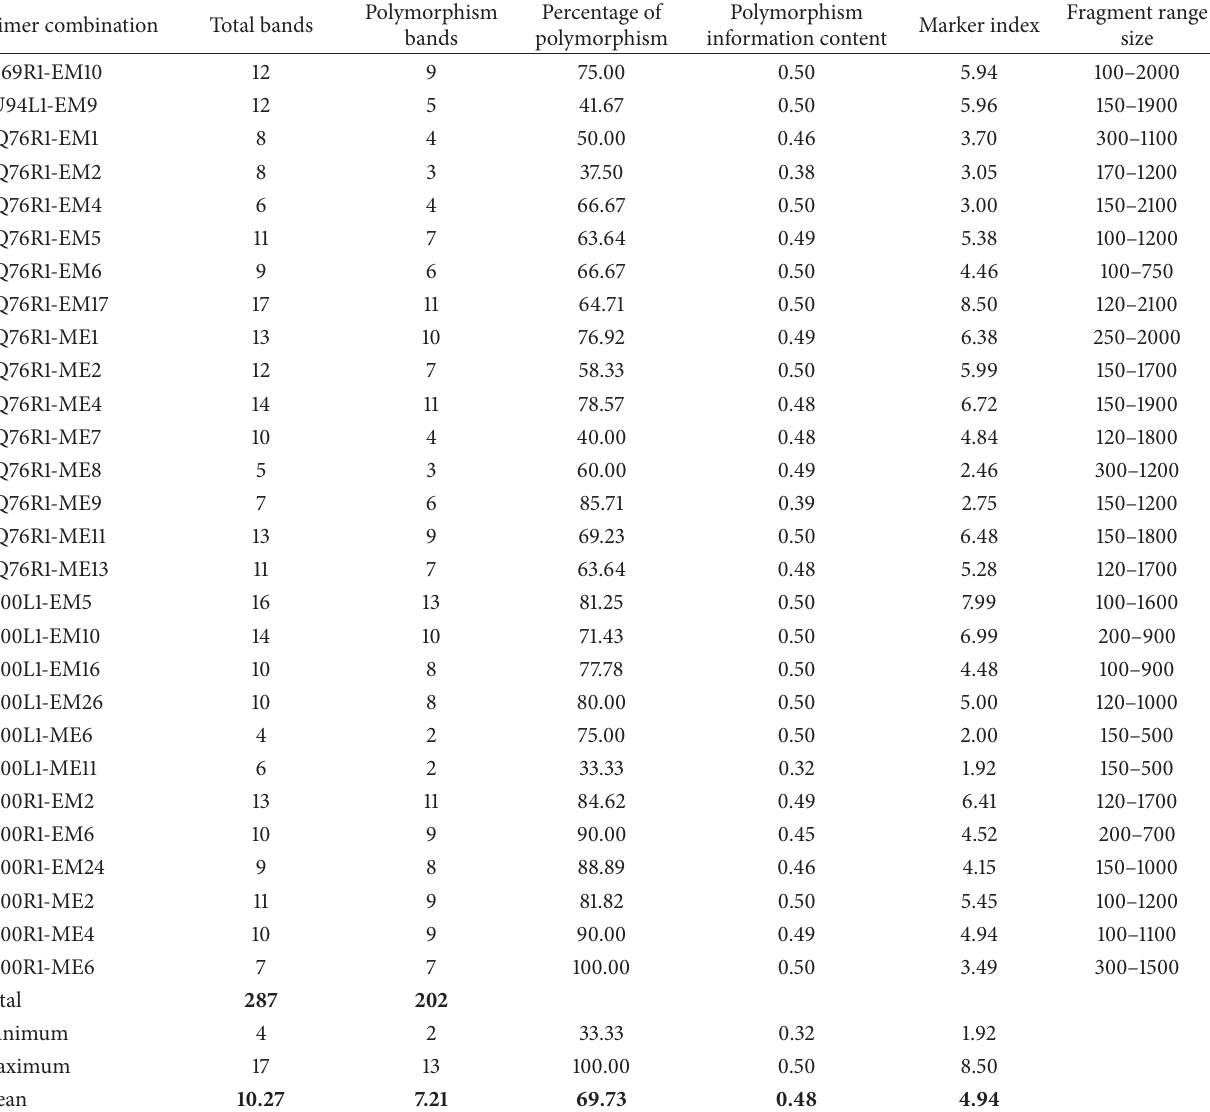
Table 1: Primer combinations and some genetic information generated by TRAP